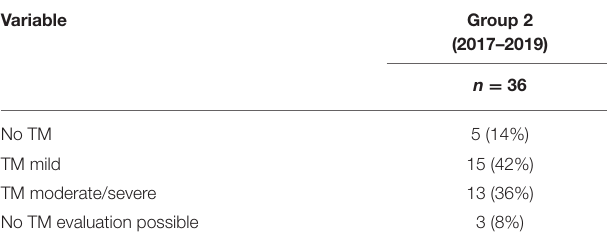
TABLE 4 | Tracheomalacia evaluated during bronchoscopy before EA repair in group 2.